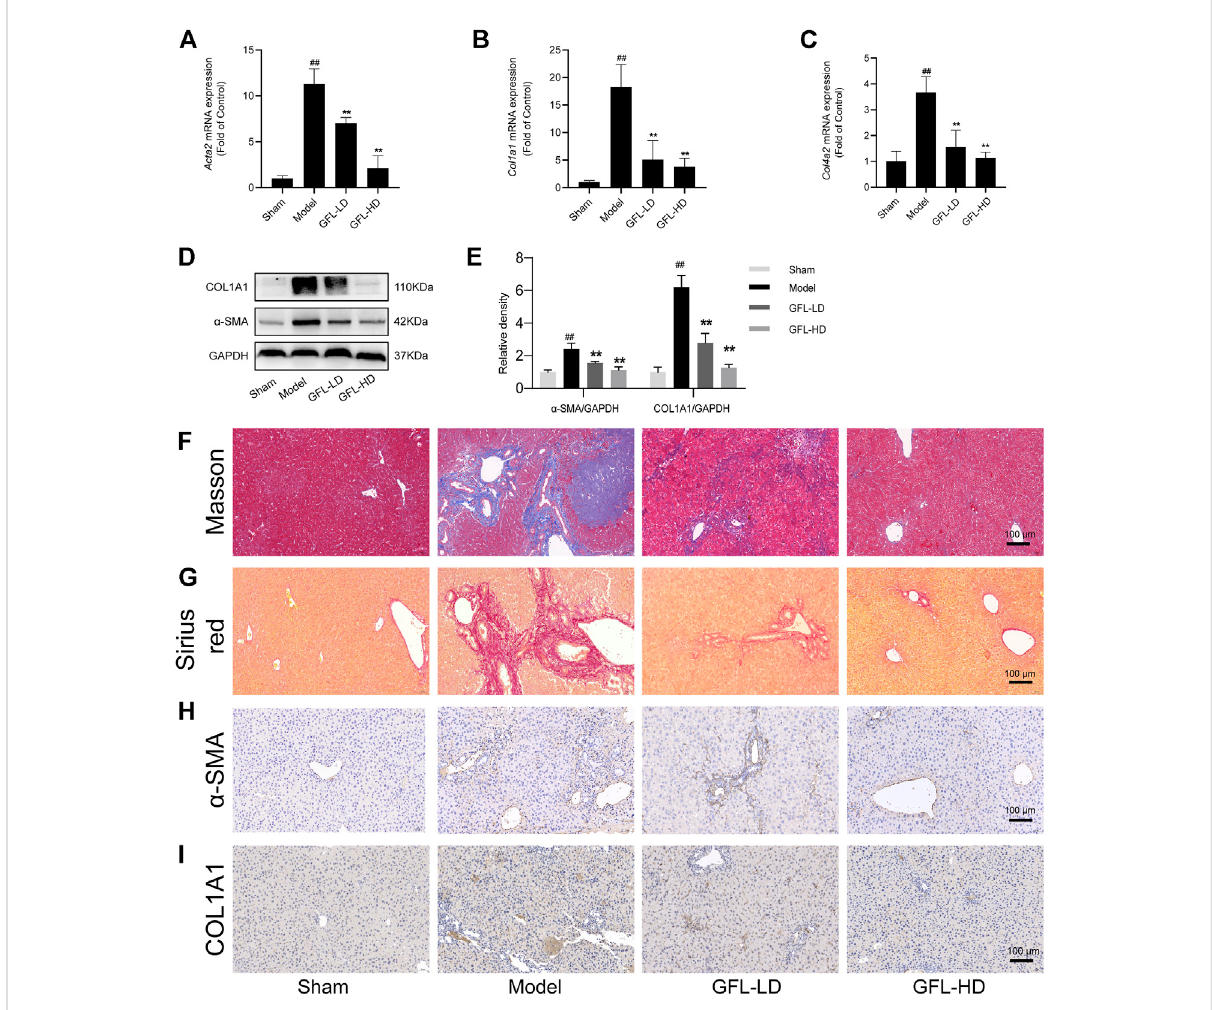
FIGURE 3 Effects ofGFLon liver fi brosis inmice. mRNA expressionof (A) α -SMA, (B) COL1A1, and (C) COL4A2 intheliver. (D) Protein expressionof α -SMA and COL1A1 in the liver. (E) Protein expression statistics of α -SMA and COL1A1. (F) Representative MASSON-stained images of liver tissue sections (×200 magni fi cation). (G) Representative Sirius red-stained images of liver tissue sections (×200 magni fi cation). Representative (H) α -SMA and (I) COL1A1 immunohistochemical images of liver tissue sections (×200 magni fi cation). Data are expressed as the mean ± SD, n = 6. Data were analyzed using one-way ANOVA. # p < 0.05, ## p < 0.01 compared to the sham group. * p < 0.05, ** p < 0.01 compared to the model